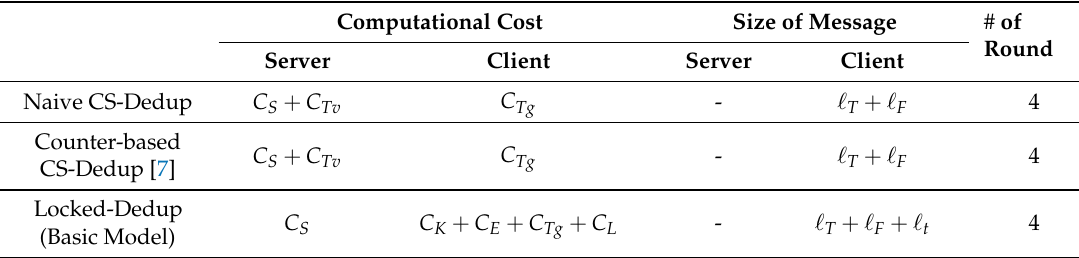
Table 1. Cost of the upload procedure for locked